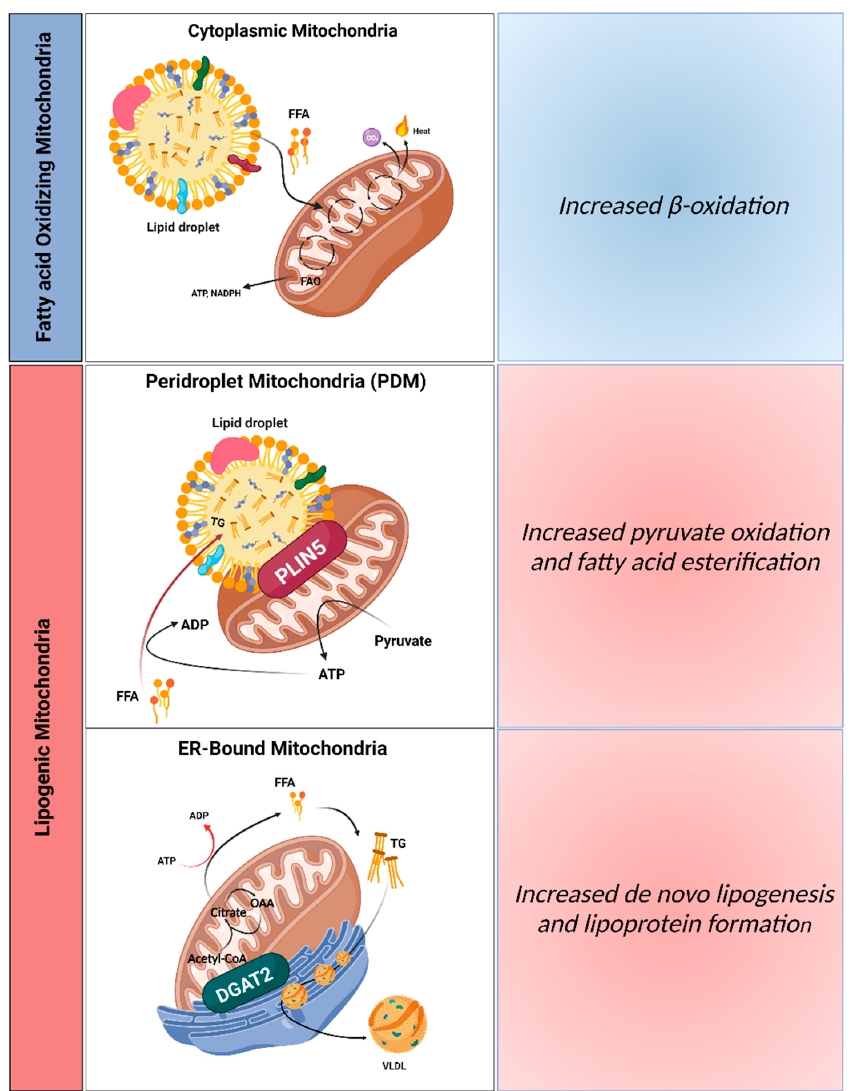
Figure 1. Distinct mitochondrial populations in hepatocytes. Mitochondria attached to different organelles can have distinct roles, reinforcing the hypothesis that not all mitochondria in the same cell are homogeneous. This concept supports the assumption that some mitochondria in hepatocytes can be specialized in synthesizing lipids, while other mitochondria can oxidize lipids. The functional segregation of mitochondria can be determined by their anchorage to specific organelles, which prevents motility and thus fusion between the different subpopulations. In this context, it is believed that three mitochondrial populations exist in hepatocytes: (1) cytosolic mitochondria, which are responsible for fatty acid oxidation, production of ketone bodies, and ureagenesis to support glucose production; (2) mitochondria attached to lipid droplets, namely peridroplet mitochondria (PDM), which promote the esterification of fatty acids into triglycerides; and (3) ER-anchored mitochondria, responsible for fatty acid synthesis, lipoprotein assembly, and excretion. VLDL, very low-density lipoprotein; PLIN5, perilipin 5; DGAT2, diacylglycerol O-acyltransferase 2; ER, endoplasmic reticulum; OAA, oxaloacetate. Created with BioRender.com.